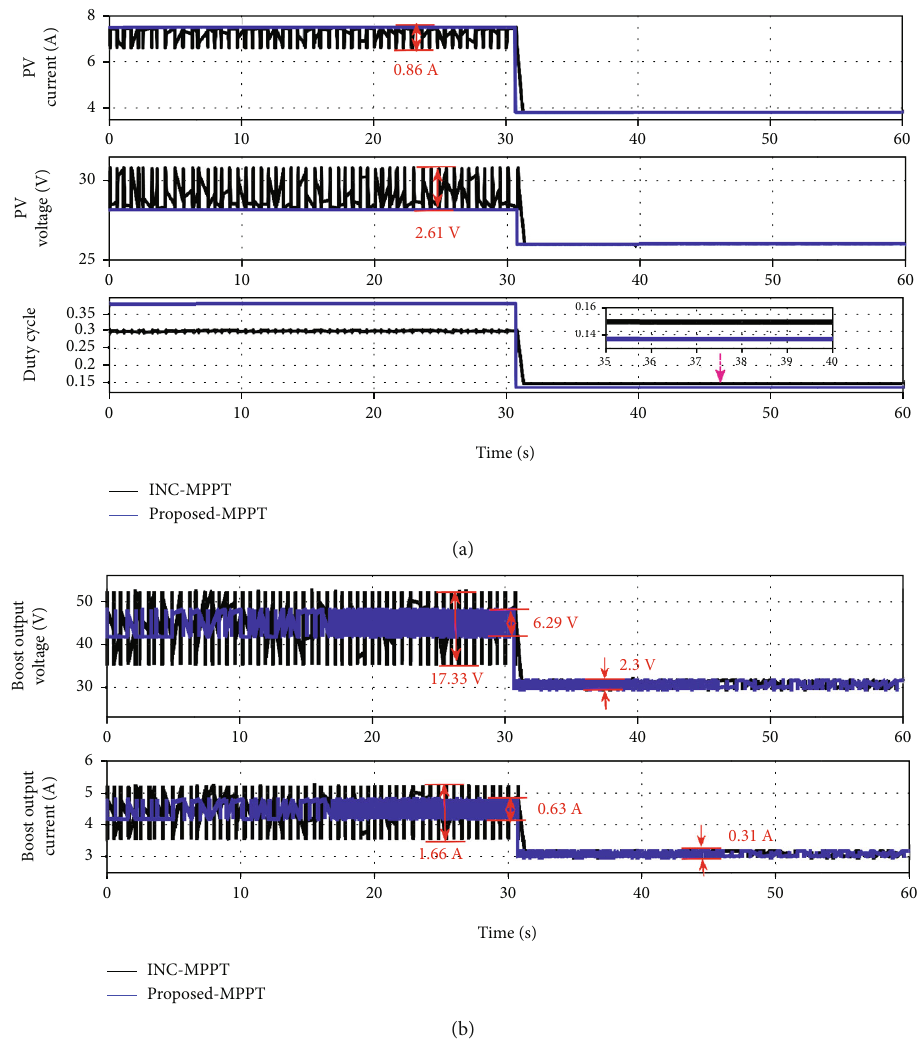
Figure 30: RT-LAB real-time results of both MPPT schemes under the sudden insolation change: (a) PV array output current and voltage with duty ratio curves and (b) boost converter output current and voltage